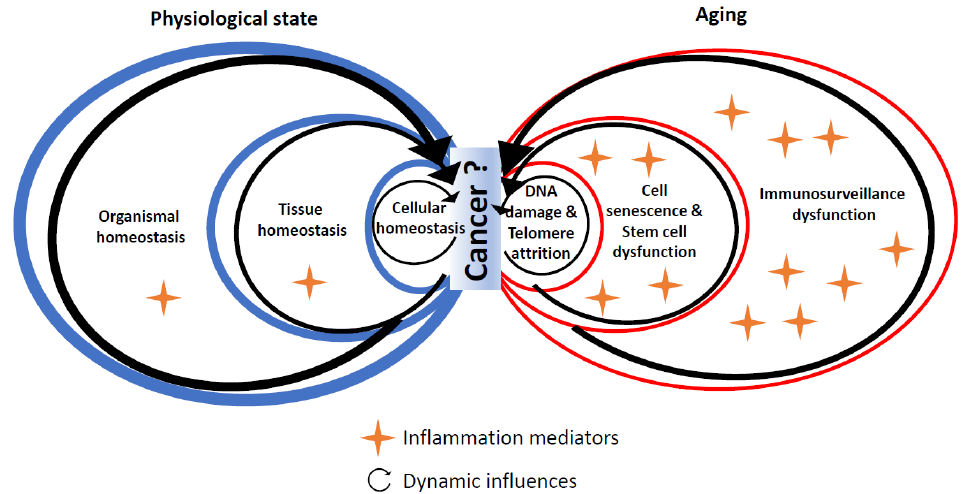
Figure 2. Interplay of factors associated with homeostasis, aging and inflammation in cancer devel- opment.